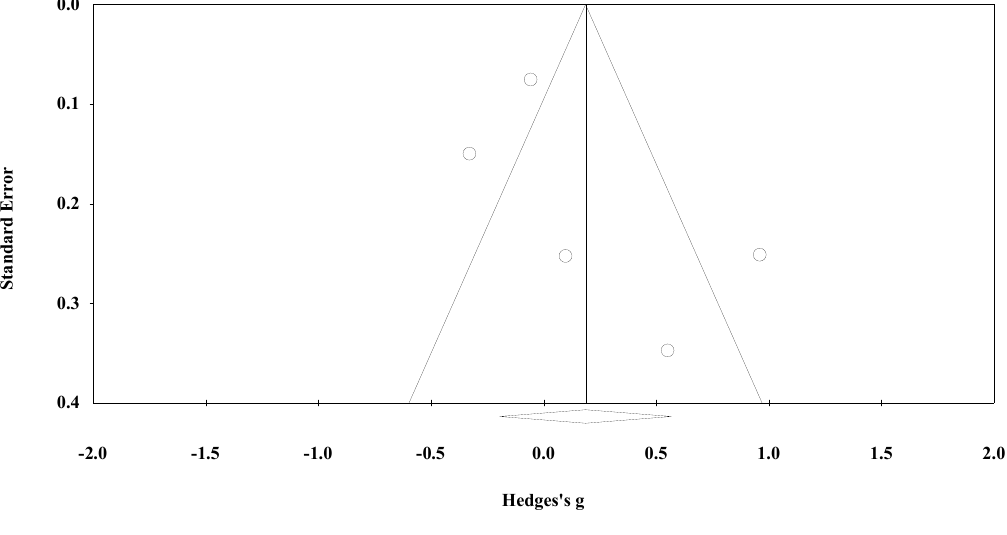
Funnel Plot for the Random Effect Model (Face-to-face vs. Synchronous) for the Affective Domain